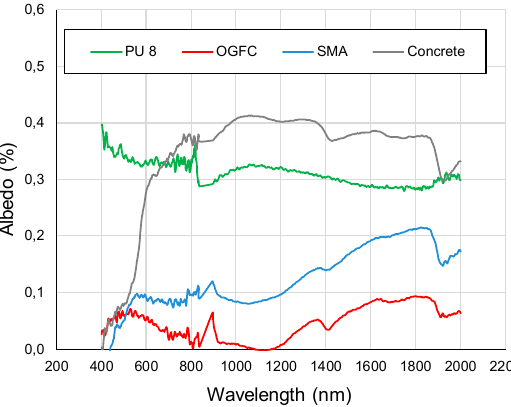
Figure 8. Simulation of solar radiation using iodine tungsten lamp.